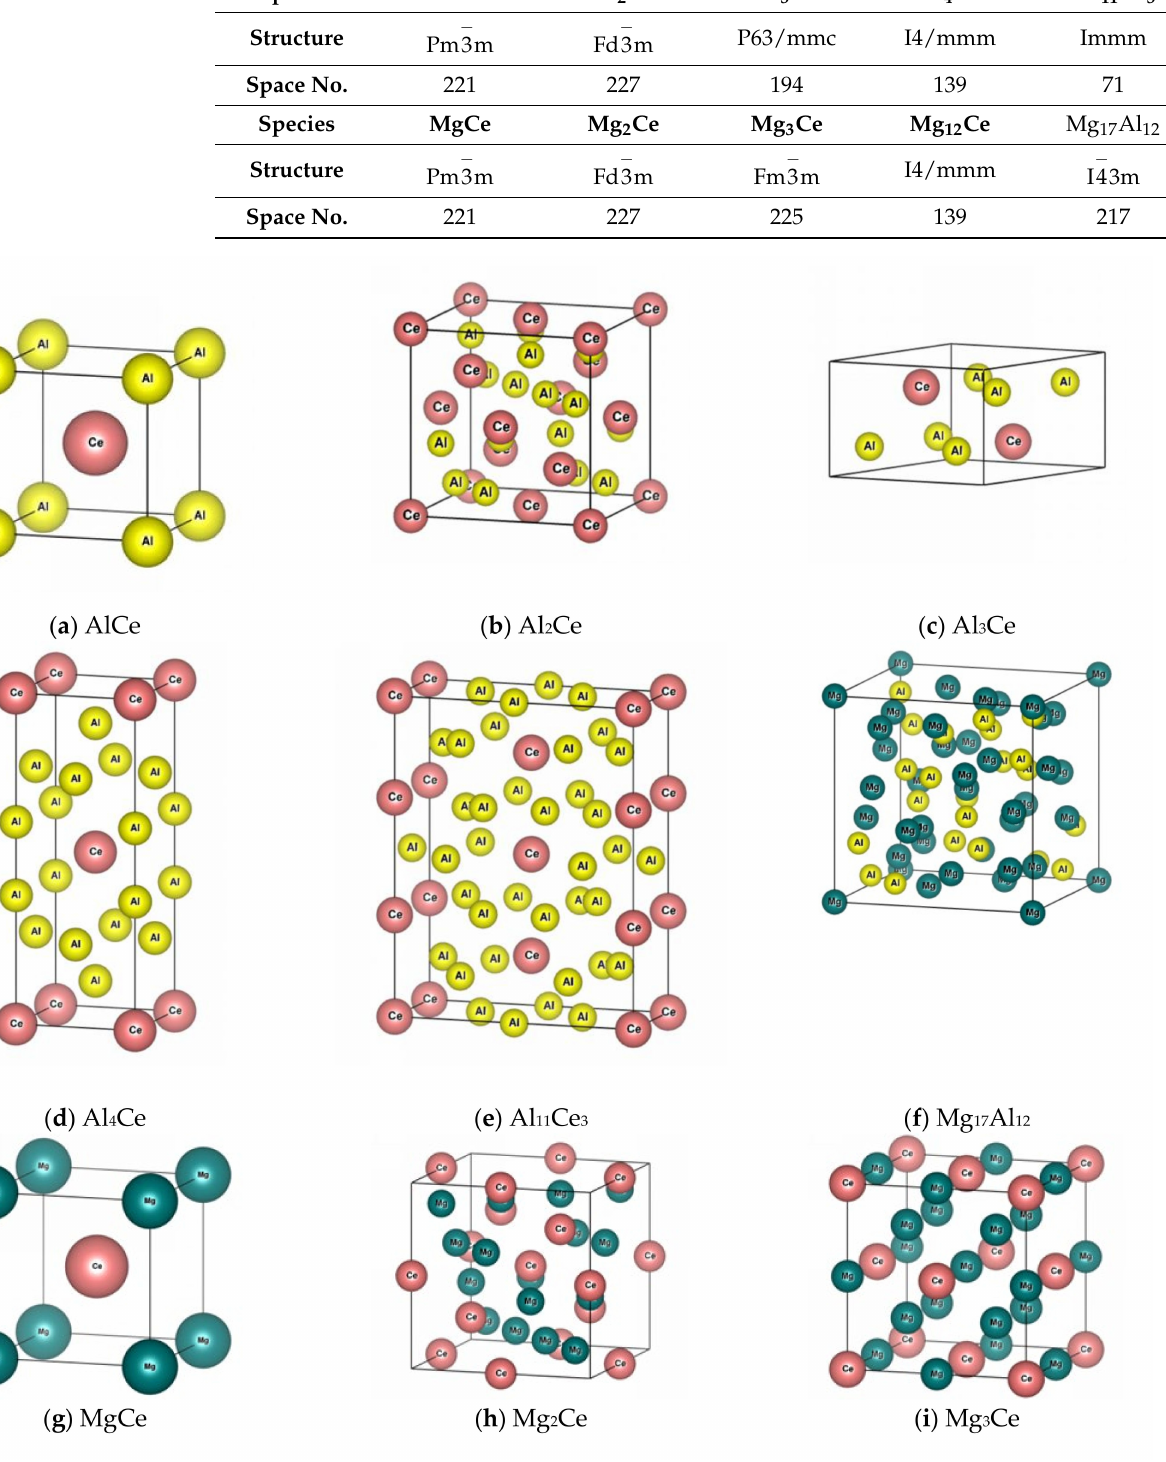
Table 2. The possible second phases in Mg-Al-Ce ternary alloy.